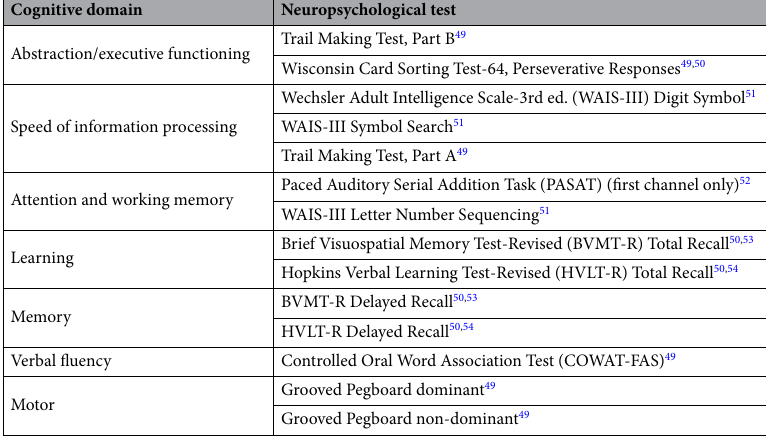
Table 1. Neuropsychological test battery used to generate T scores among HIV-infected participants of National NeuroAIDS Tissue Consortium